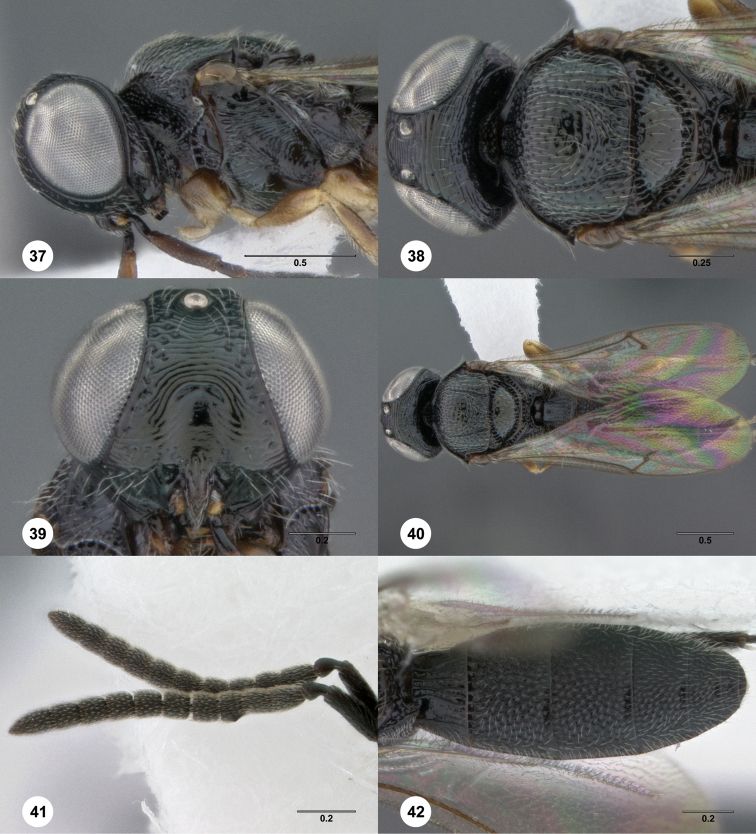
Oxyscelio circulorum sp. n., holotype female (OSUC 225606) 37 Head and mesosoma, lateral view 38 Head and mesosoma, dorsal view 39 Head, anterior view 40 Metasoma, dorsal view. Paratype male (OSUC 148409) 41 Antenna 42 Metasoma, dorsal view. Morphbank34